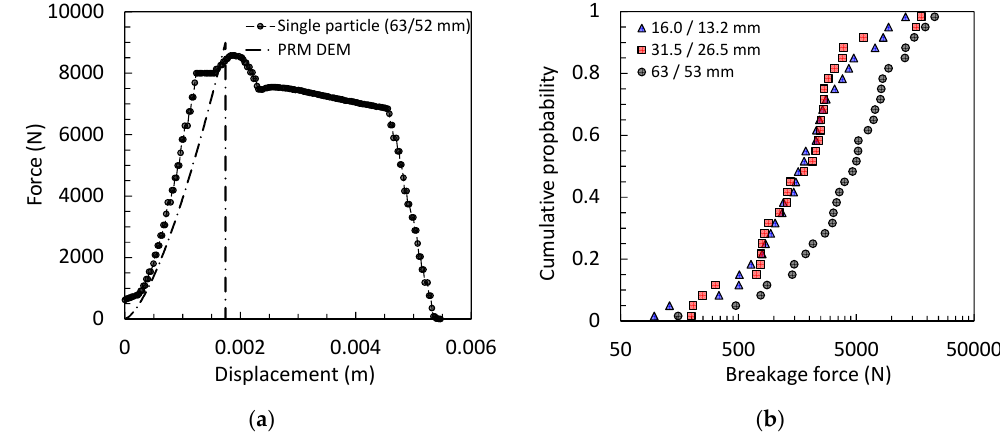
Figure 6. Force-deformation profile of a single particle compression test (experiment and simulation) ( a ) and distribution of breakage forces for three size classes ( b ).